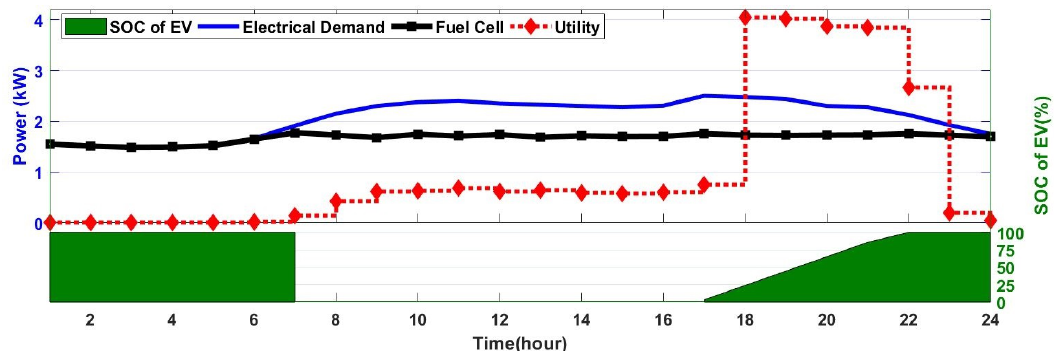
Figure 8. Case 3: Charging of electric vehicle (EV) without scheduling.